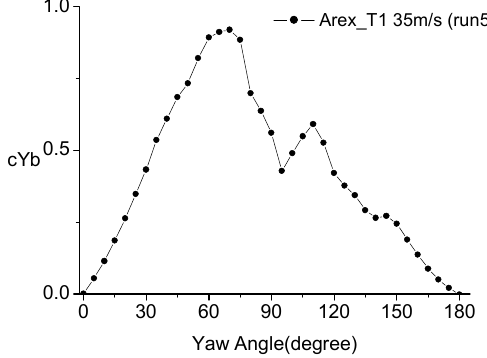
Figure 9 Side force coefficient (AREX